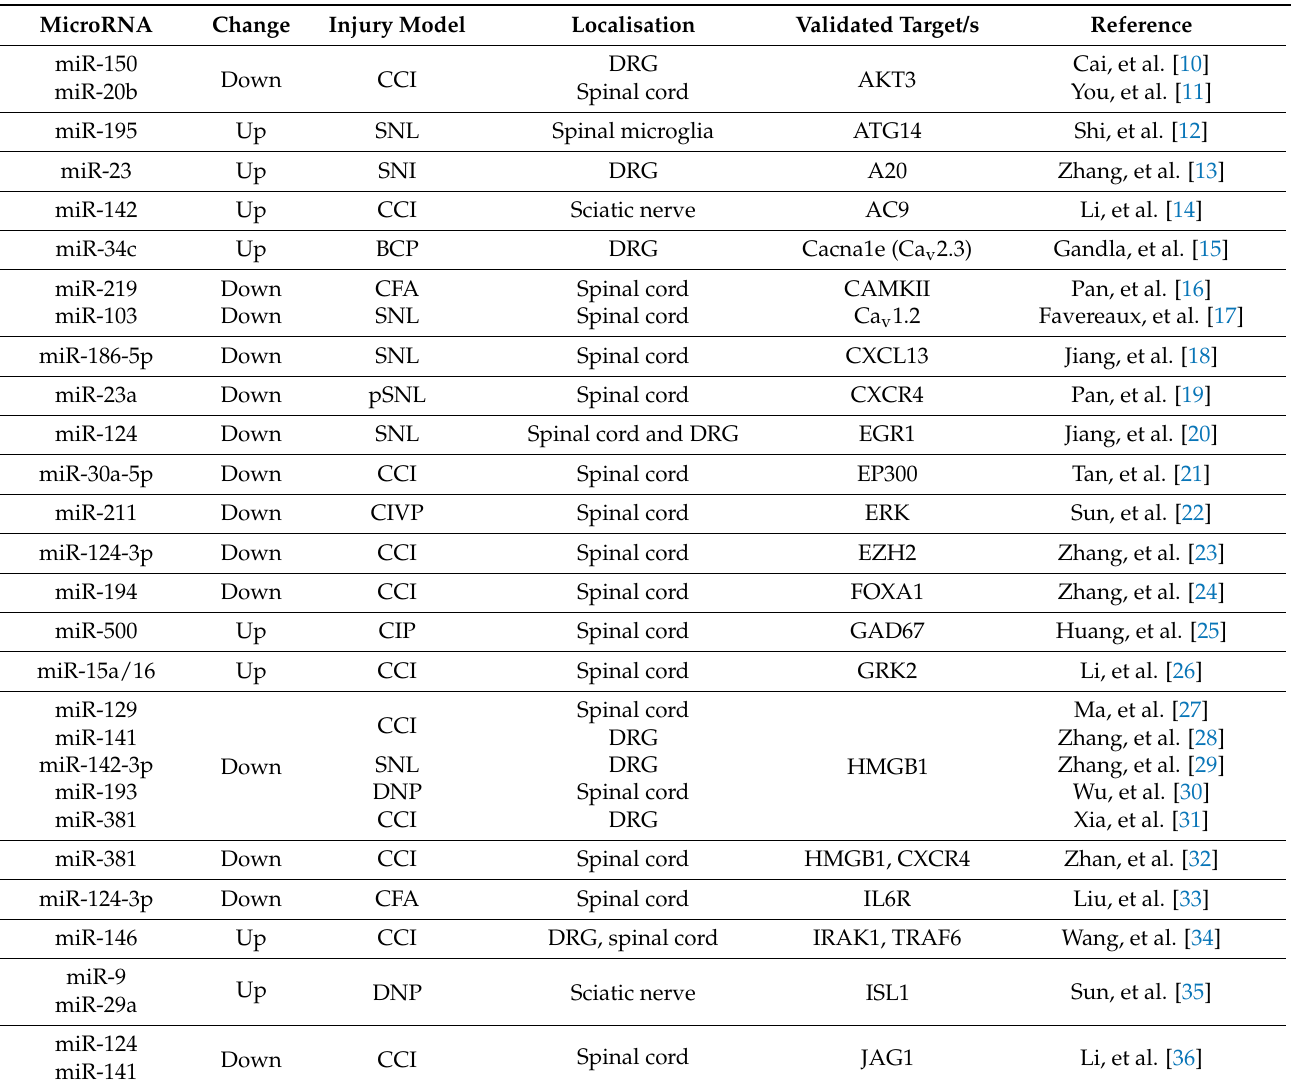
Table 1. List of dysregulated miRNAs in various chronic pain animal models and the